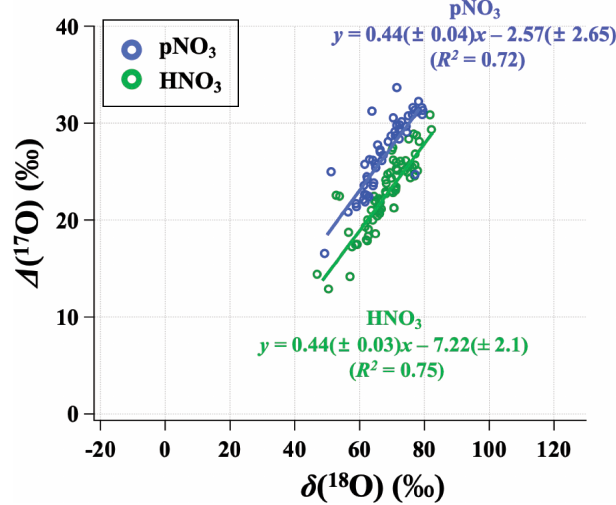
Figure 6. Relationship between the monthly mean ( δ ( 18 O) and (cid:49) ( 17 O)) for observed HNO 3 (green) and pNO 3 (blue) across all CASTNET sites, with correlation coefficient ( R 2 ) and slope.